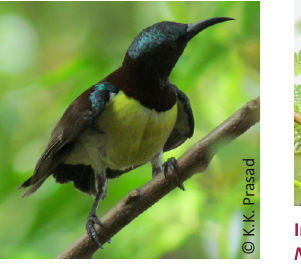
Image 66. Purple-rumped Sunbird Nectarinia zeylonica